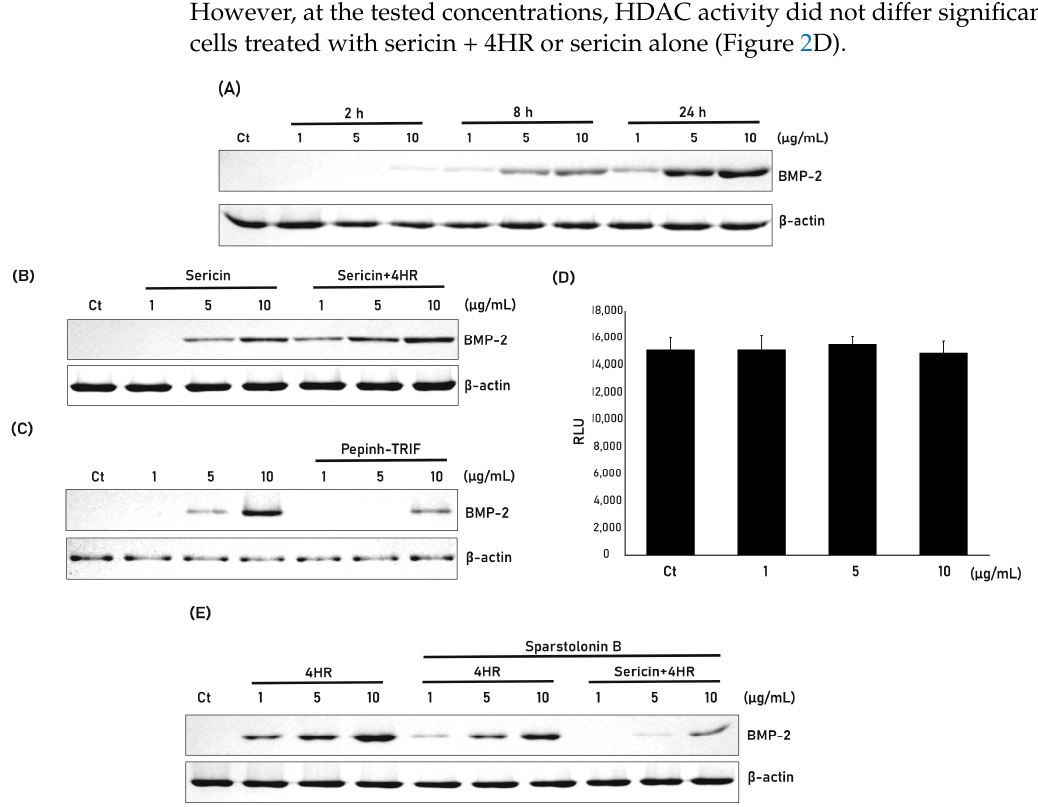
Figure 2. Effect of 4HR pretreatment of silk sericin on BMP-2 expression in RAW264.7 cells. ( A ) Western blot analysis of BMP-2 expression by RAW264.7 cells treated with 1, 5, and 10 µg/mL 4HR-sericin for 2, 8, and 24 h. ( B ) Western blot analysis of BMP-2 expression by cells treated with 1, 5, and 10 µ g/mL sericin and 4HR-sericin. The relative expression level to β -actin was shown in Supplementary Figure S3. ( C ) Mechanisms by which sericin and 4HR induce BMP-2 expression. 4HR mainly induces BMP-2 expression by inhibiting histone deacetylase (HDAC), whereas sericin mainly induces BMP-2 via a Toll-like receptor (TLR) mediated pathway. TRIF is a mediator of the TLR signaling pathway. Pretreatment of cells with a peptide inhibiting TRIF (Pepinh-TRIF) prior to sericin + 4HR administration reduced BMP-2 expression, indicating that induction of BMP-2 expres- sion by sericin + 4HR was mediated mainly by the TLR signaling pathway. ( D ) Effect of 4HR and sericin + 4HR on HDAC activity. Although 4HR is a strong inhibitor of HDAC activity, sericin + 4HR did not inhibit its activity ( p > 0.05). ( E ) Effect of sparstolonin B, an inhibitor of TLR2 and TLR4, on BMP-2 expression induced by 4HR and sericin + 4HR. RAW264.7 cells were incubated with 1, 5, and 10 µ g/mL 4HR, 4HR plus sparstolonin B or sericin + 4HR plus sparstolonin B, and BMP-2 ex- pression was analyzed by western blotting.